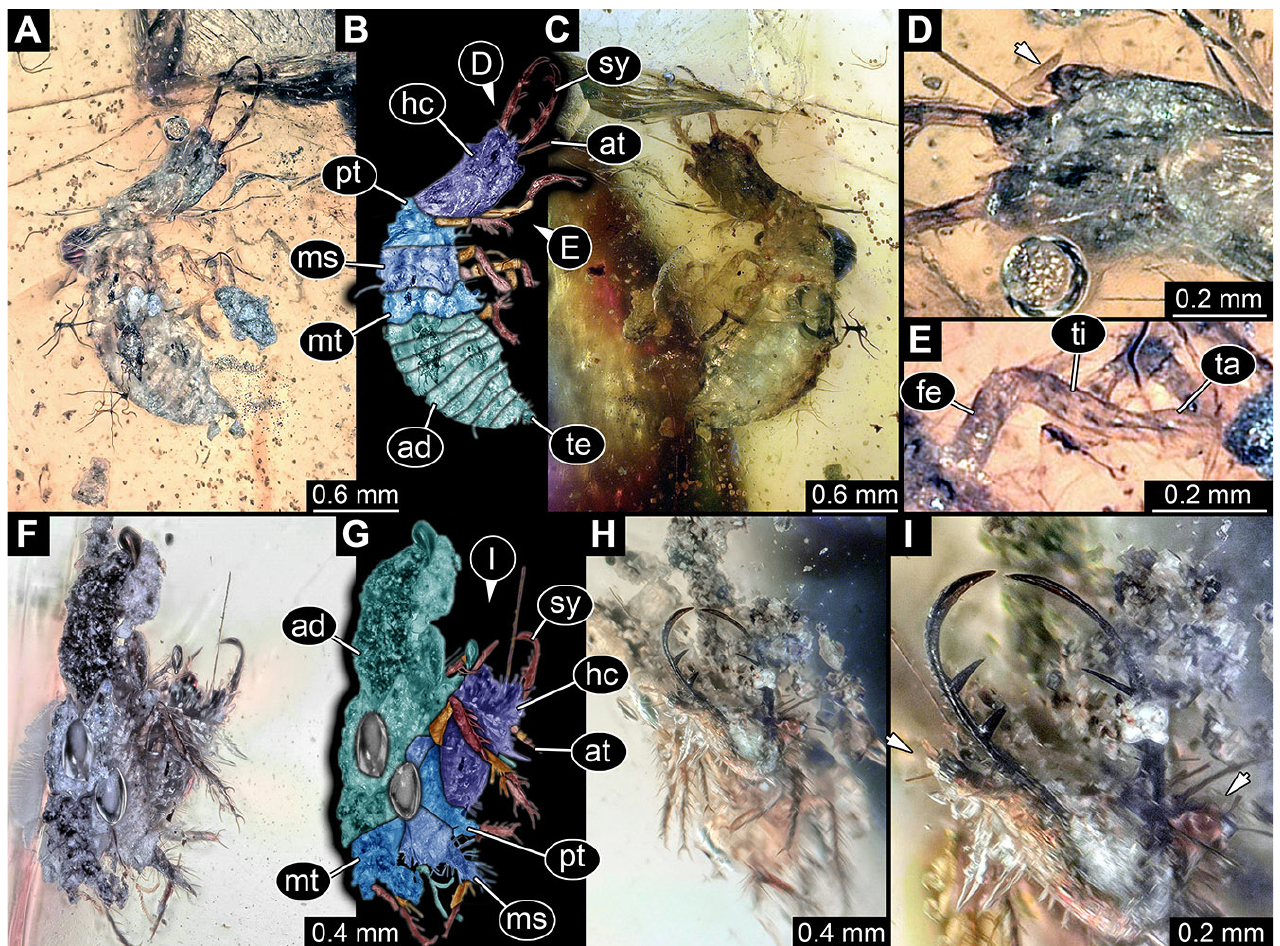
Figure 13. Fossil owllion larvae, Cretaceous Kachin amber, Myanmar. ( A – E ) Specimen 3225 (CJW F 3199). ( A ) Overview, oblique dorsal. ( B ) Color-marked version of ( A ). ( C ) Overview, oblique ventral. ( D ) Close-up on head capsule with field of stemmata (arrow). I Close-up on locomotory appendage. ( F – I ) Specimen 3226 (CJW F 3421). ( F ) Overview, antero-lateral. ( G ) Color-marked version of ( F ). ( H ) Overview, anterior. ( I ) Close-up on head capsule, with fields of stemmata (arrows). Abbreviations: ad = abdomen; at = antenna; fe = femur; hc = head capsule; ms = mesothorax; mt = metathorax; pt = prothorax; sy = stylet; ta = tarsus; te = trunk end; ti = tibia.